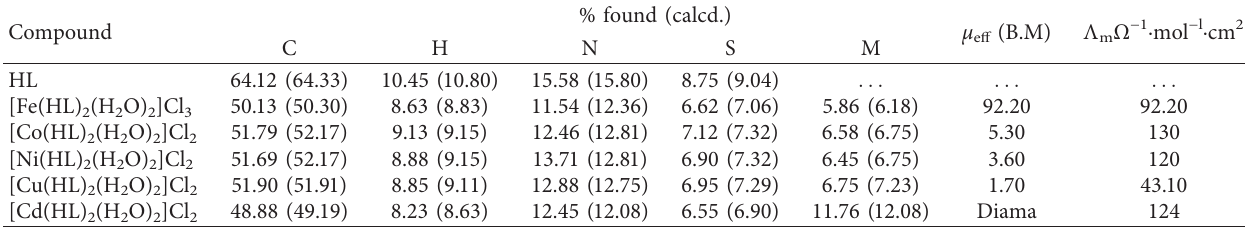
Table 1: Elemental and physical data of triazole ligand and its metal complexes. % found Compound